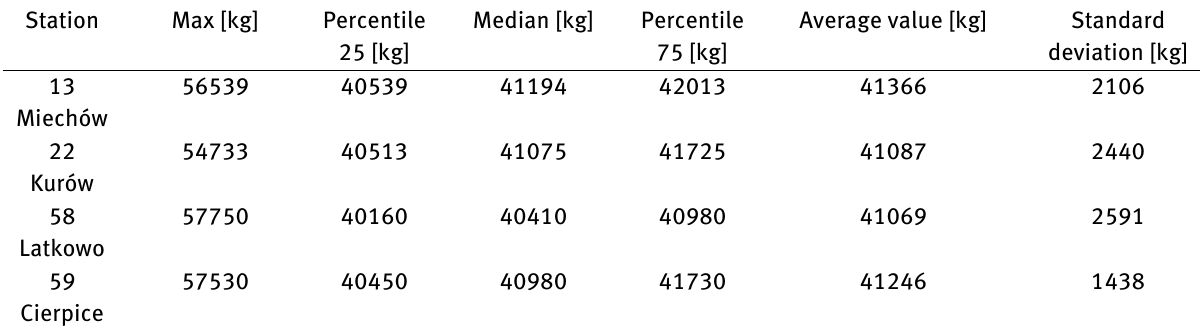
Table 3: Descriptive statistics for the gross weight of overloaded category 9 vehicles Station Max